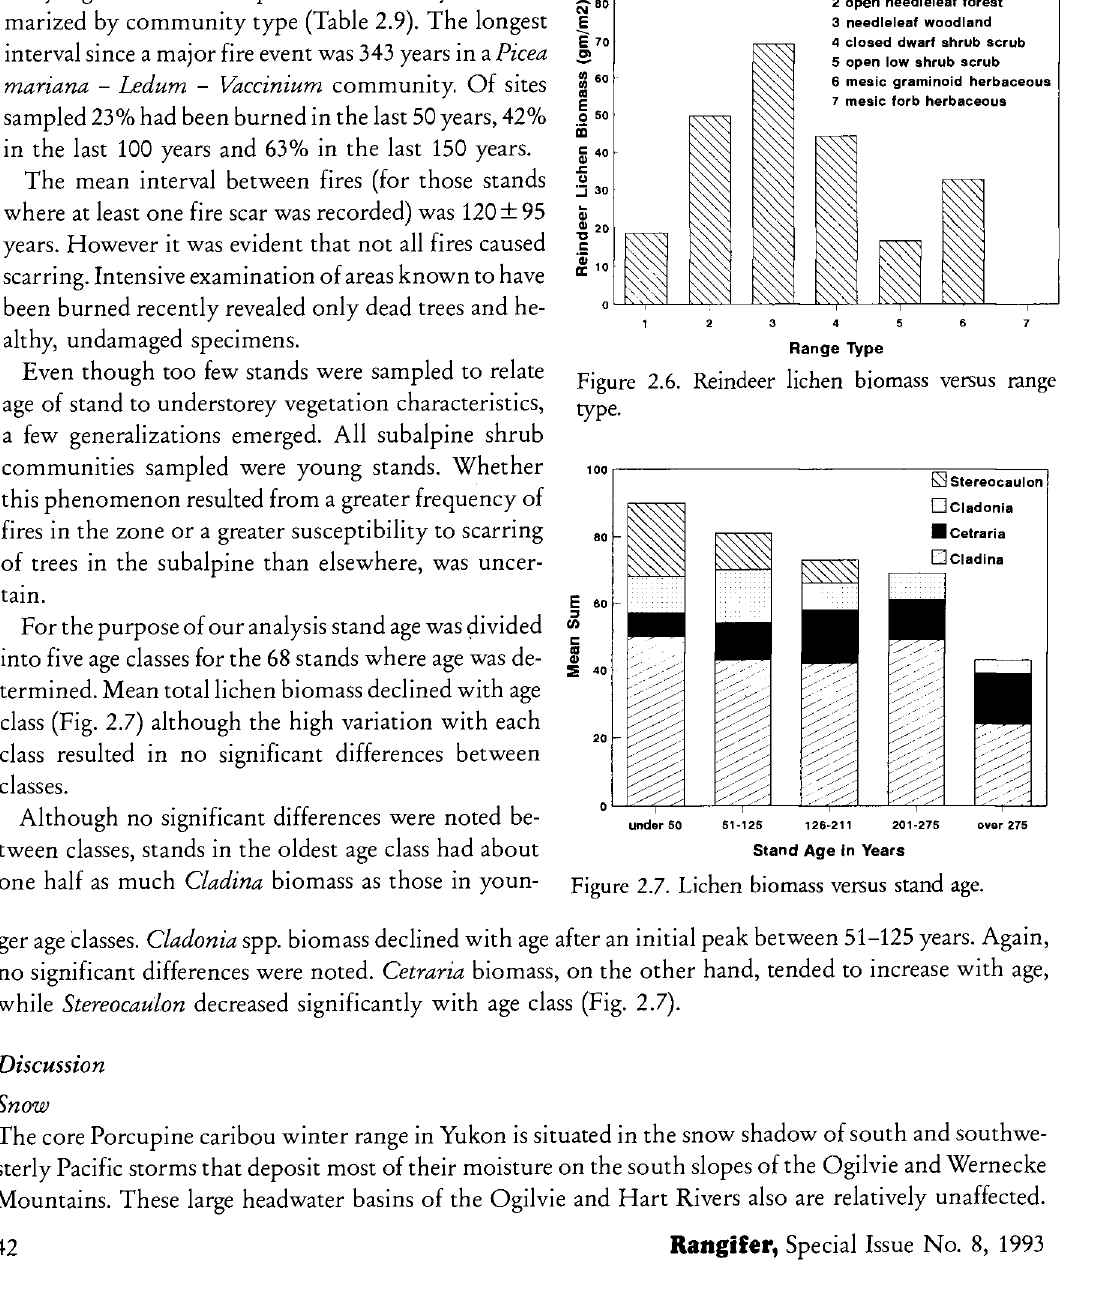
Figure 2.6. Reindeer lichen biomass versus range type.